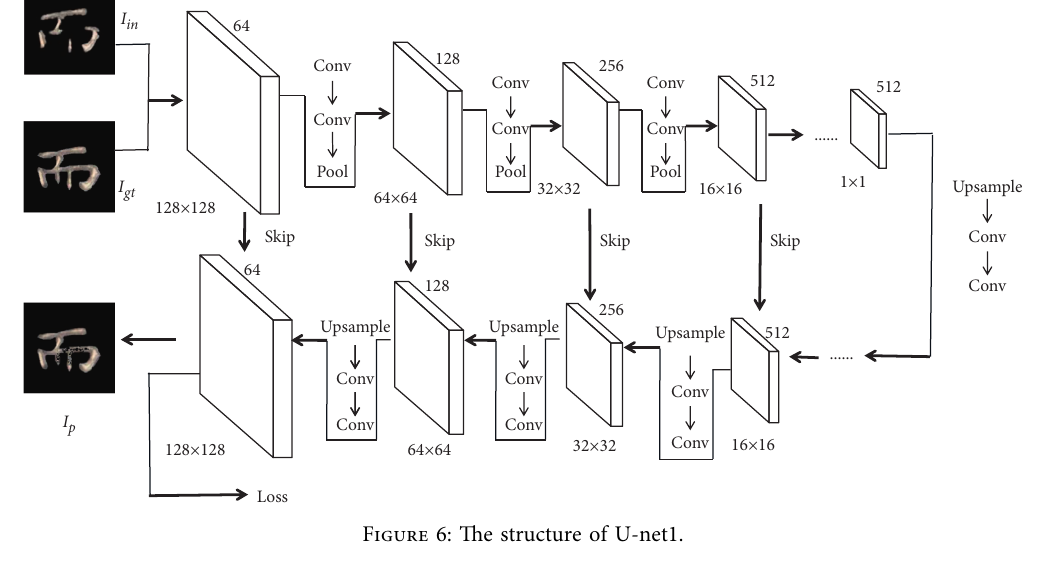
Figure 6: The structure of